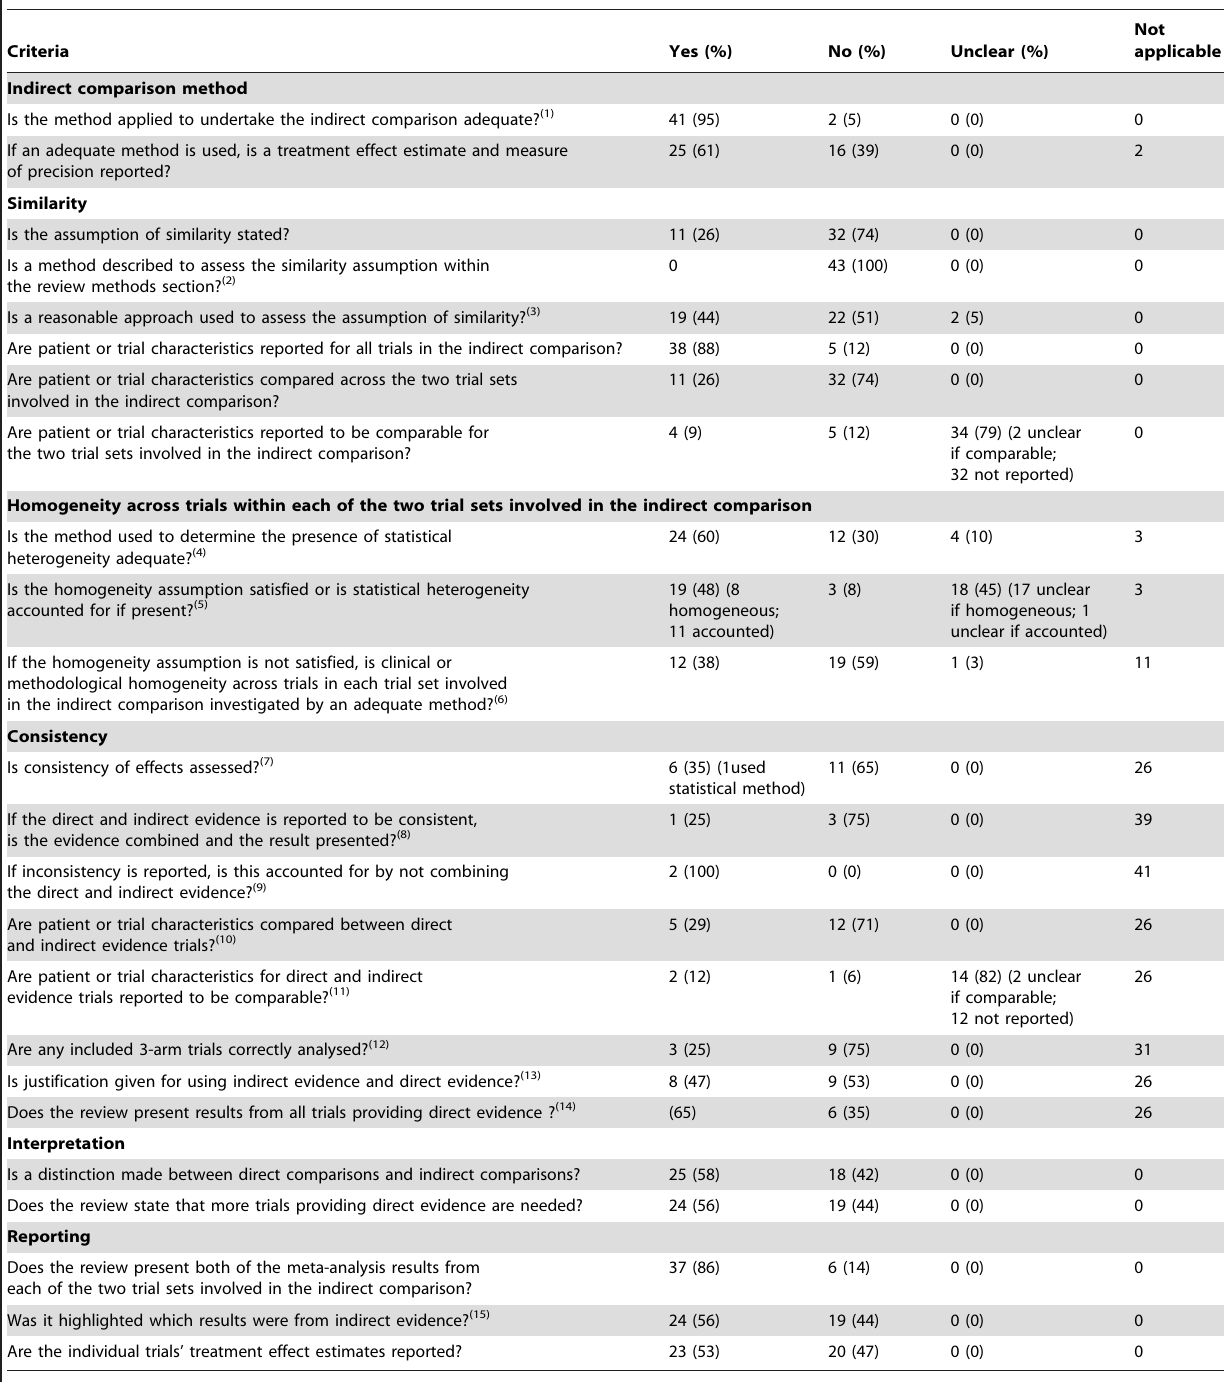
Table 1. Summary of quality assessment